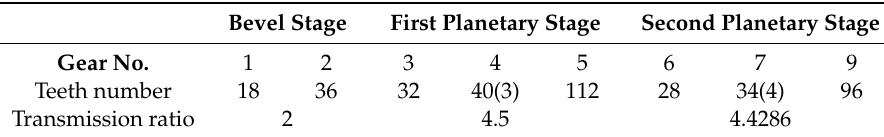
Figure 16. Planetary gearbox test rig: ( a ) test rig image; ( b ) test rig schematic diagram. Table 3. Parameters of test rig.